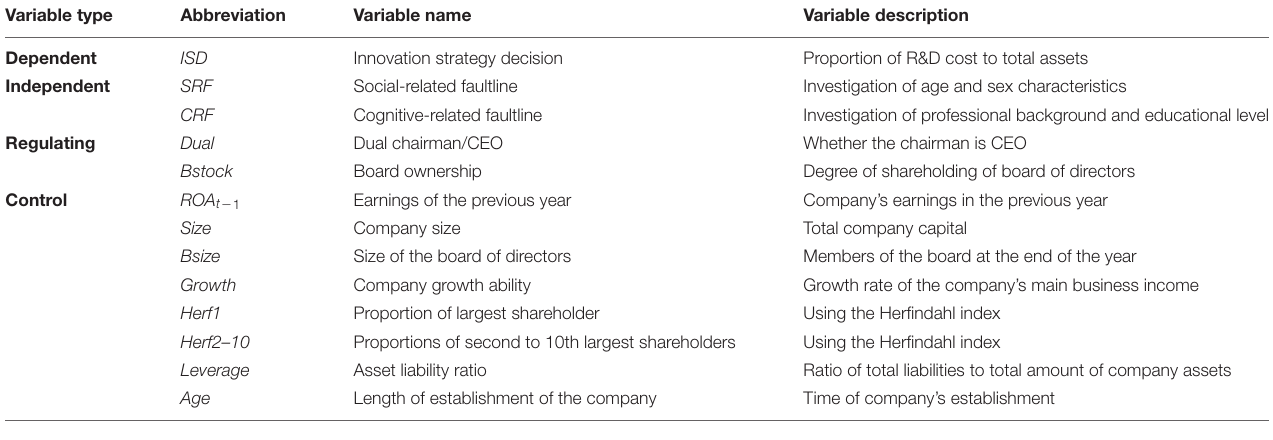
TABLE 2 | Correlations coefficient of each